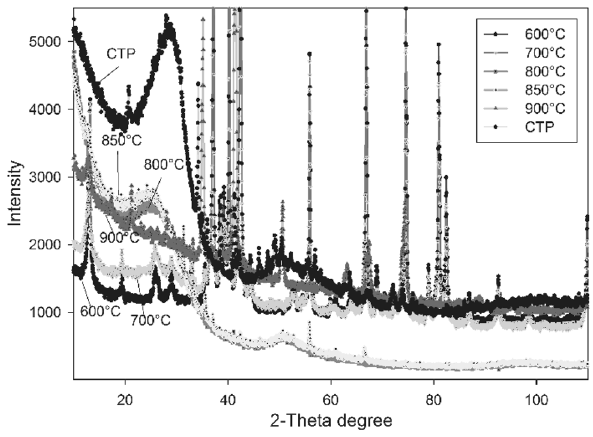
Fig. 1 TGA/DSC results for CTP